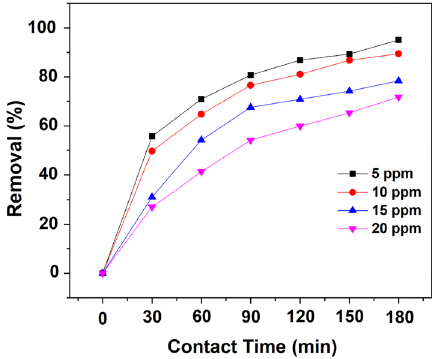
Fig. 7 Effect of initial concentration on Cr(VI) on the adsorption effi- ciency of CTAB–kaolin (50